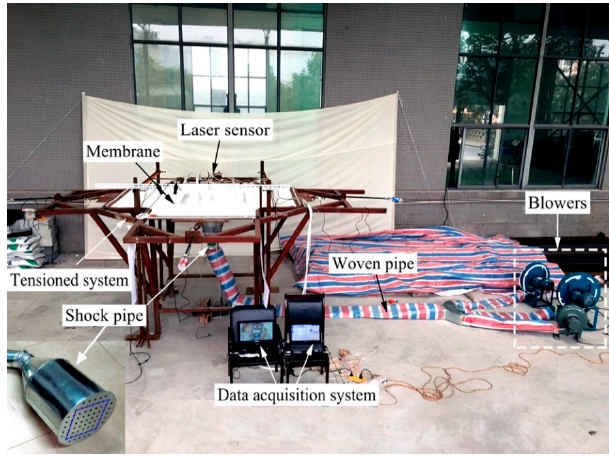
Figure 5. Photo of whole experimental system. Table 1. Parameters of the high-pressure blower.